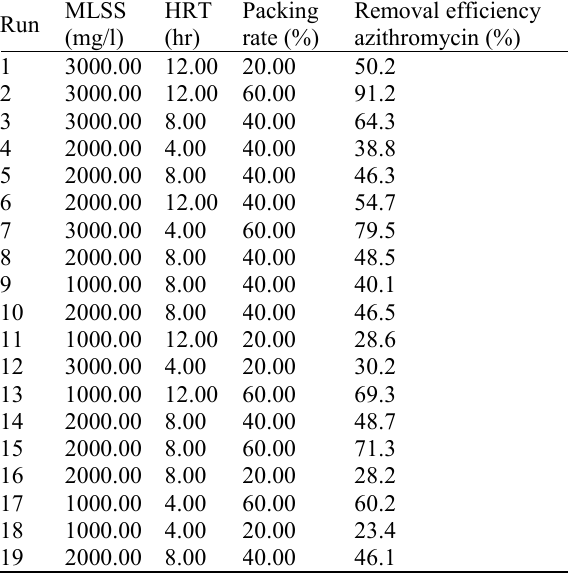
Table 2. Antibiotic removal efficiency values based